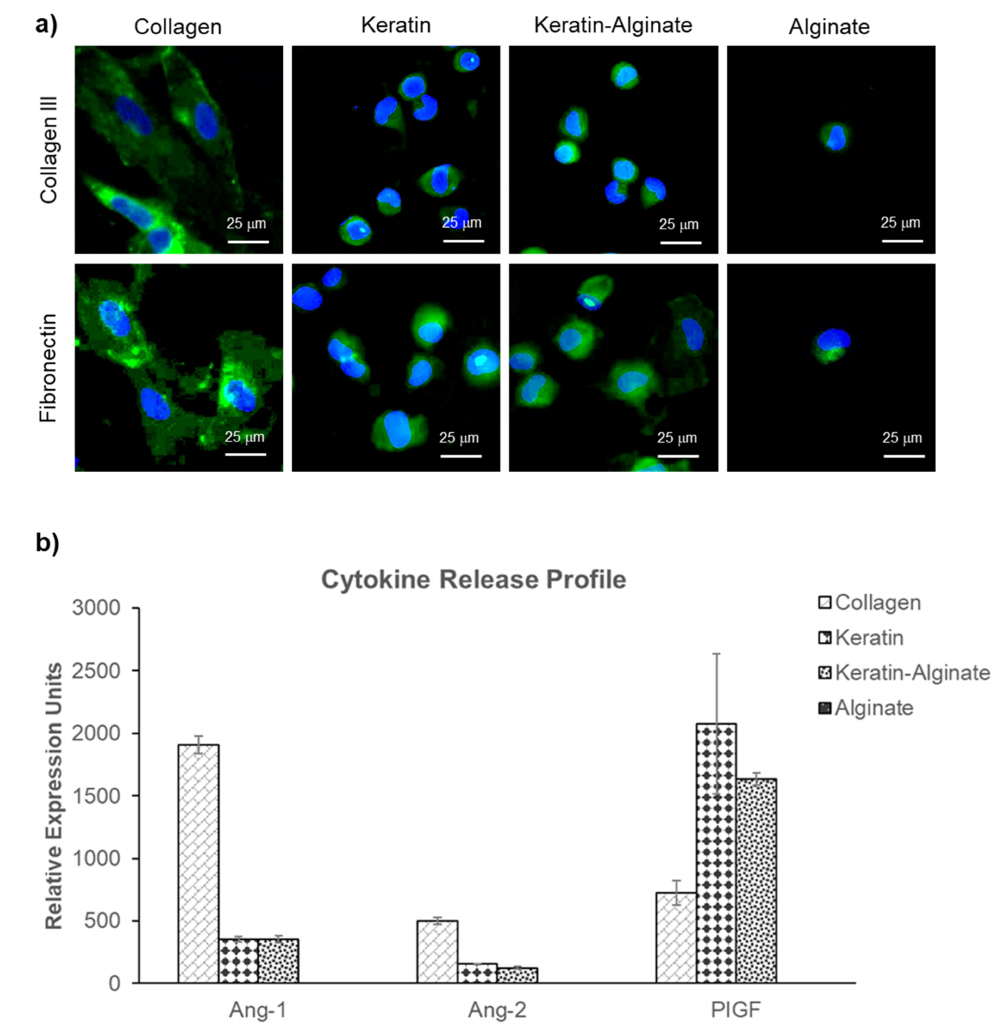
Figure 3. Evaluation of extracellular matrix (ECM) expression and cytokine release of HDFs after culturing for 14 days in collagen, keratin, keratin–alginate, and alginate matrices. ( a ) Immunofluorescence staining of collagen III and fibronectin. Collagen III/fibronectin and cell nuclei were stained green and blue, respectively (scale bar: 25 µ m). ( b ) Relative secretion of Ang-1, Ang-2, and PlGF cytokines. Each bar represents mean ± SD ( n =